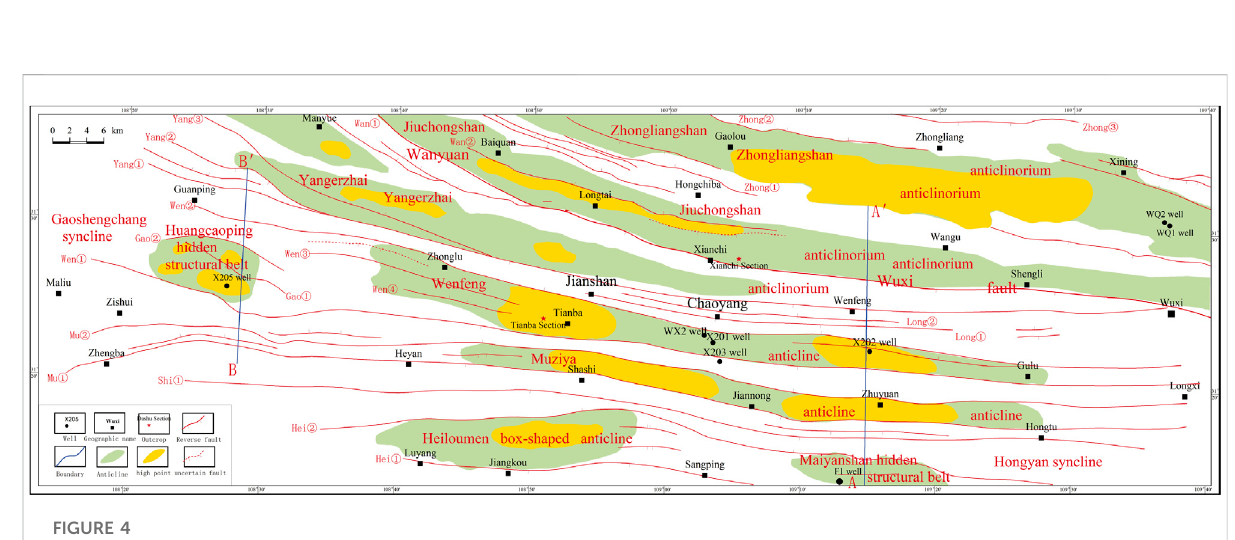
FIGURE 3 A − A ′ seismic-structural pro fi le in the study area.